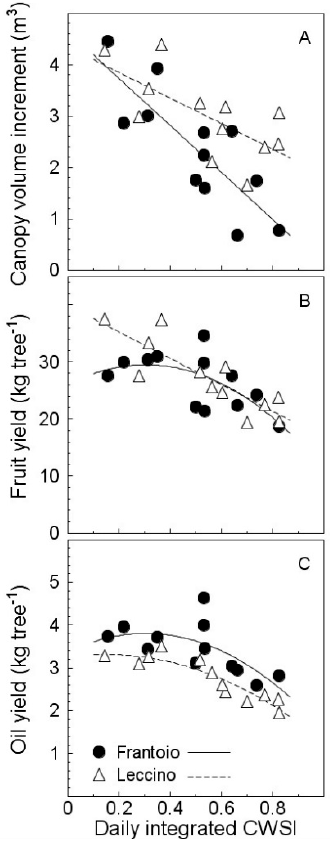
Figure 7. The relationship between daily integrated CWSI (DICWSI) calculated by UAV thermal imagery and canopy volume increment (CV), fruit yield (FY) and oil yield (OY) of olive trees (cvs. Frantoio and Leccino) subjected to full irrigation, deficit irrigation, and rainfed conditions in 2020. Each symbol represents one tree. Regression equations: ( A ) CV = − 4.58 DICWSI + 4.65 (R 2 = 0.68) (Frantoio); CV = − 2.49 DICWSI + 4.34 (R 2 = 0.47) (Leccino); ( B ) FY = − 37.566 DICWSI 2 + 22.873 DICWSI + 26.021, R 2 = 0.45 (Frantoio); FY = − 0.993 DICWSI + 39.902 (R 2 = 0.72) (Leccino); ( C ) OY = − 4.696